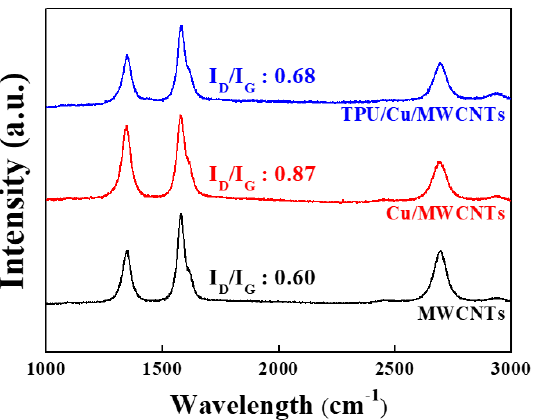
Figure 4. Polarized Raman spectra of TPU/Cu/MWCNTs, Cu/MWCNTs, and MWCNTs.